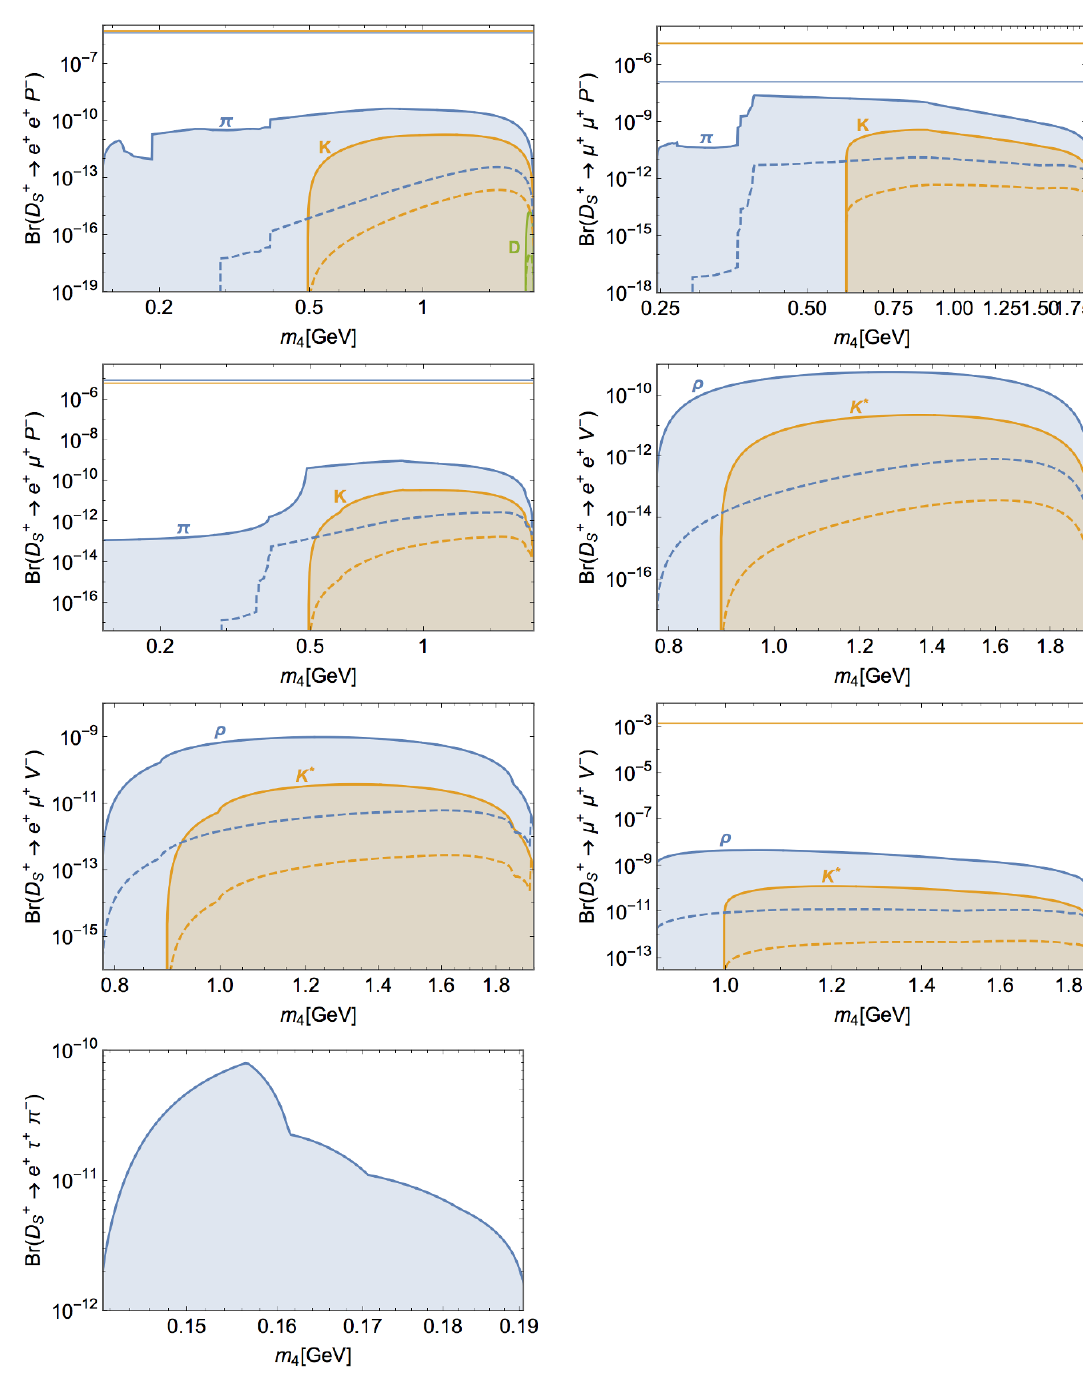
mesons (into pseudoscalar and vector s